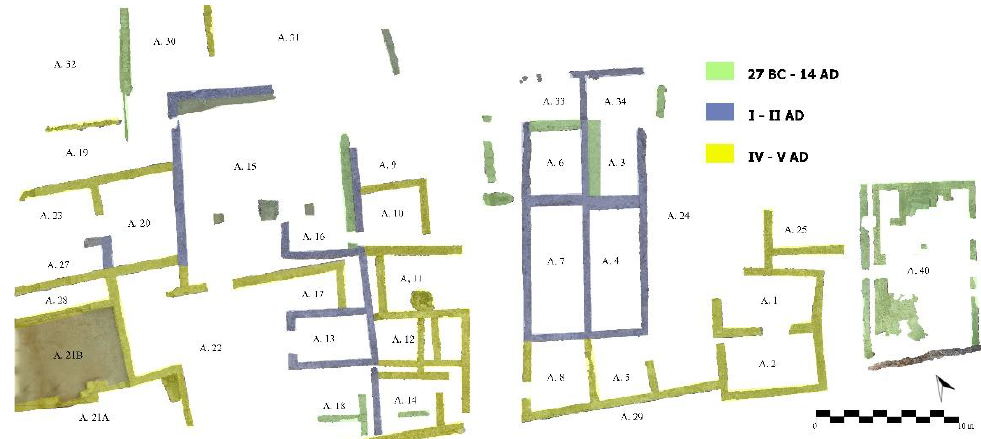
Figure 19. View of the structures exhumed in the Portus Ilicitanus plot, in which those belonging to each chronology are marked in colour. It shows an alignment of blocks extending along the same terrace flanked by two roads [11] (p. 121, Figure 3).